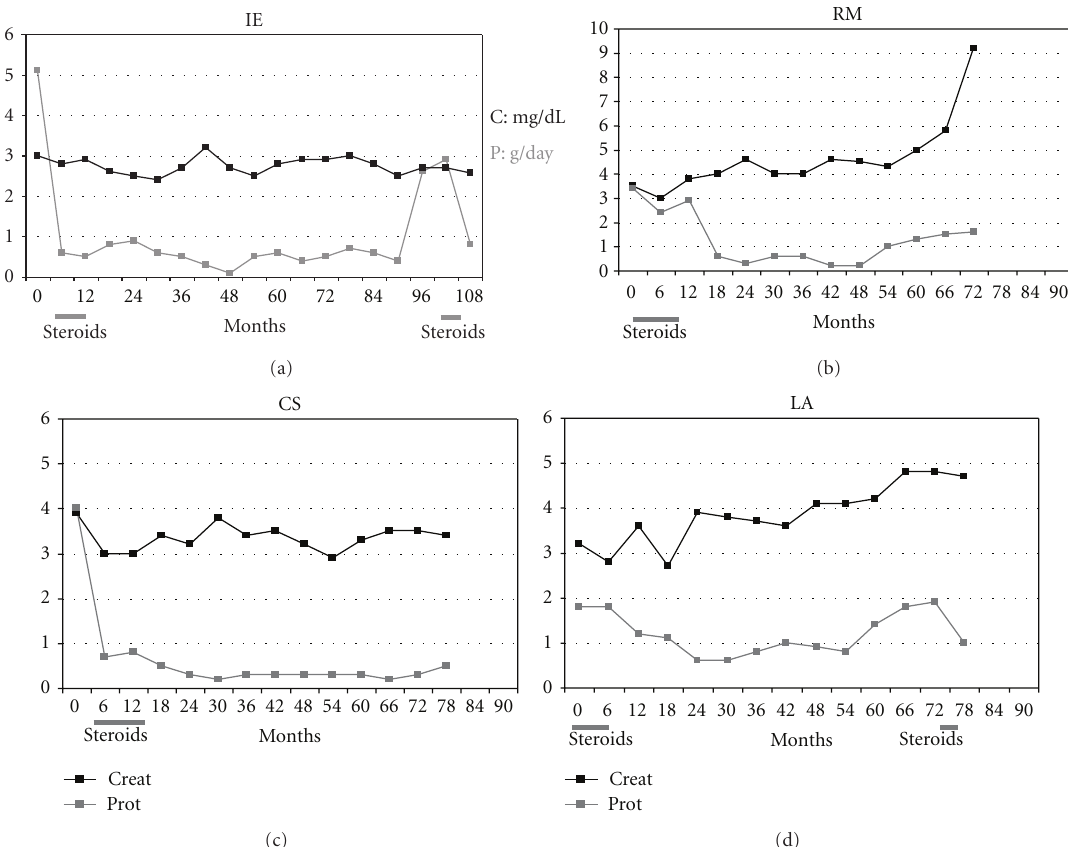
Figure 1: Trend of serum creatinine and proteinuria during the whole follow up in the four cases (evaluated every 6 months).